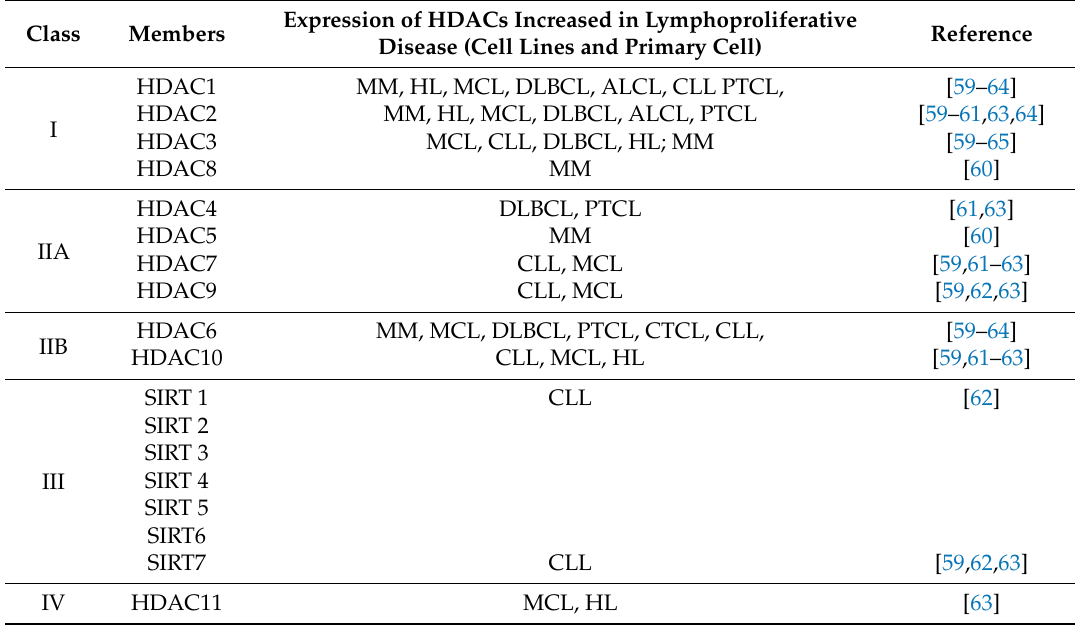
Table 2. Expression of Histone Deacetylases (HDACs) in lymphoproliferative disease. Expression of HDACs Increased in Lymphoproliferative Class Members Disease (Cell Lines and Primary Cell)